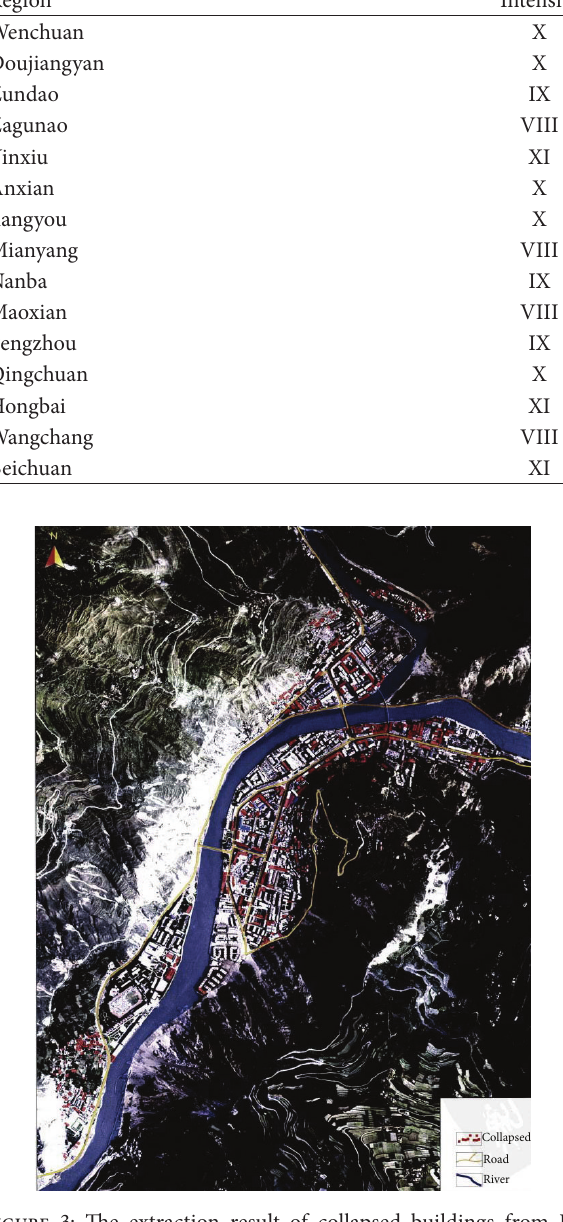
Figure 3: The extraction result of collapsed buildings from RS image.